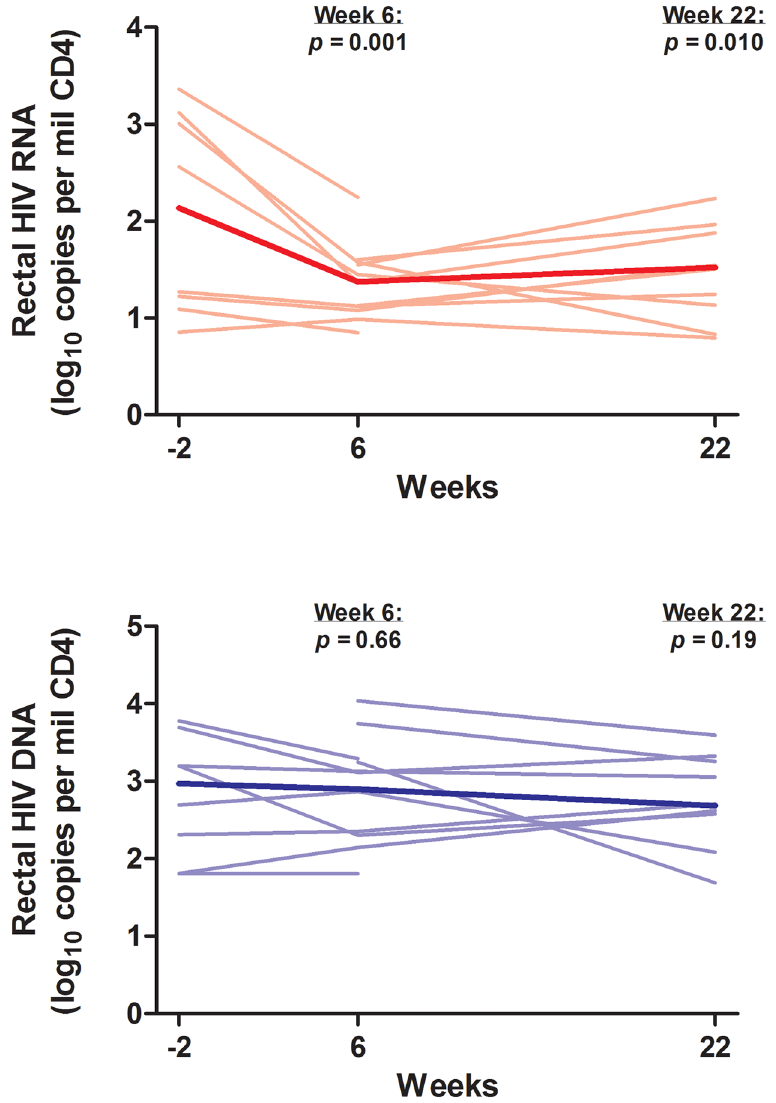
Figure 3. Change in cell-associated HIV RNA and total HIV DNA in rectum. Thin lines indicate data for each individual subject. The thick line indicates the estimated mean value over time from mixed effects linear regression. P-values refer to change from baseline at each referenced time- point.